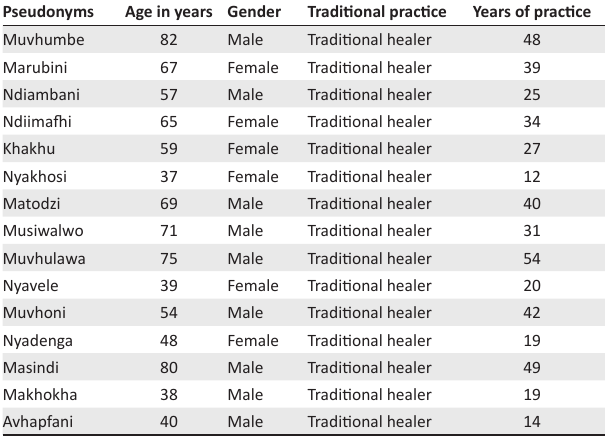
TABLE 2: Demographic data of the key informants.